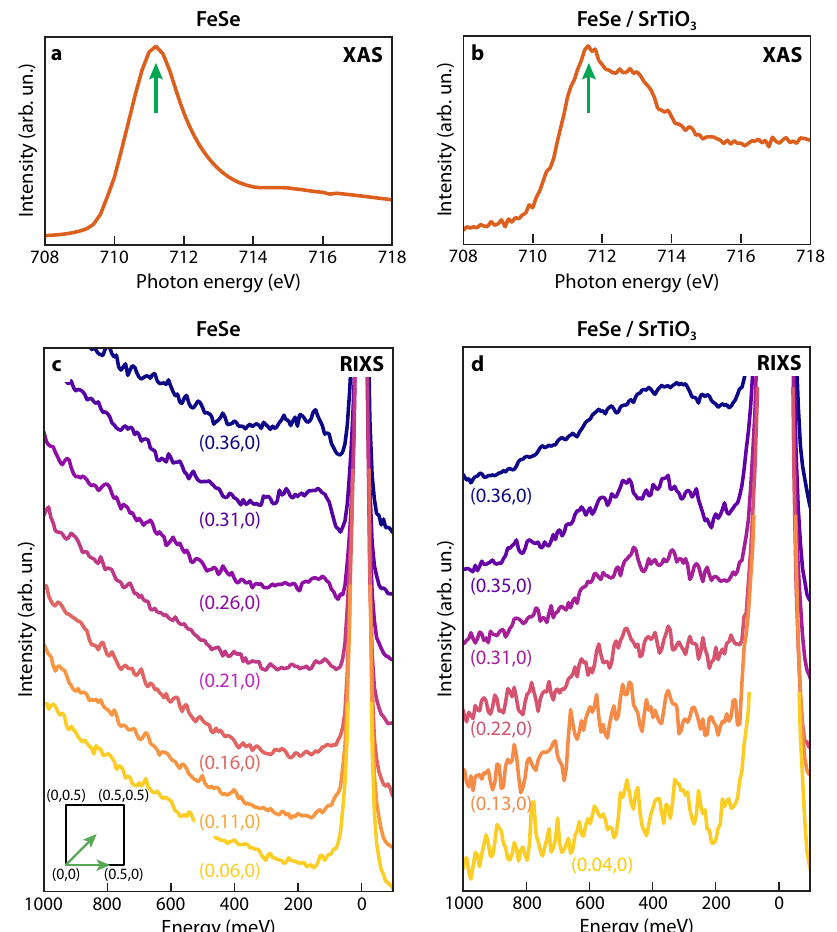
Fig. 2 X-Ray Absorption Spectroscopy (XAS) and Resonant Inelastic X-Ray Scattering (RIXS) spectra for FeSe bulk and Fe/SrTiO 3 (STO). a , b Fe L 3 - edge X-ray absorption spectra for FeSe bulk ( a ) and FeSe/STO ( b ), measured via total electron yield. The arrows mark the incident energy for the RIXS data displayed in c and d . c , d High-energy resolution RIXS spectra of FeSe bulk ( c ) and FeSe/STO ( d ) at different momentum points along the high- symmetry direction (0, 0) → ( H , 0) [RIXS spectra along the (0, 0) → ( H , H ) direction are reported in the Supplementary Resonant Inelastic X-Ray Scattering . Figure 2c, d show the corresponding high-resolution and high-statistics RIXS data on FeSe and monolayer FeSe/STO, respectively. In the bulk case, we detect a dispersive excitation at an energy of ~140 meV at q = (0.36, 0) r.l.u., which gradually decreases in energy toward the zone center until it merges into the elastic line. This mode is reminiscent of what observed in INS experiments 3 and can be ascribed to spin excitations as previously shown in ref. 14 . A word of caution should be given, however, as FeSe lacks long-range antiferromagnetism, and, instead exhibits Néel- and stripe-type fl uctuations 3 . As such, a direct comparison between the excita- tions measured by INS and RIXS is not straightforward since the Γ point is not equivalent to M or X in the absence of Brillouin zone folding. Nevertheless, the excitations of FeSe closely resemble those observed in BaFe 2 As 2 14 , suggesting that spin fl uctuations are of similar nature in these two compounds in proximity of the Γ point and across the portion of Brillouin zone accessible to RIXS.